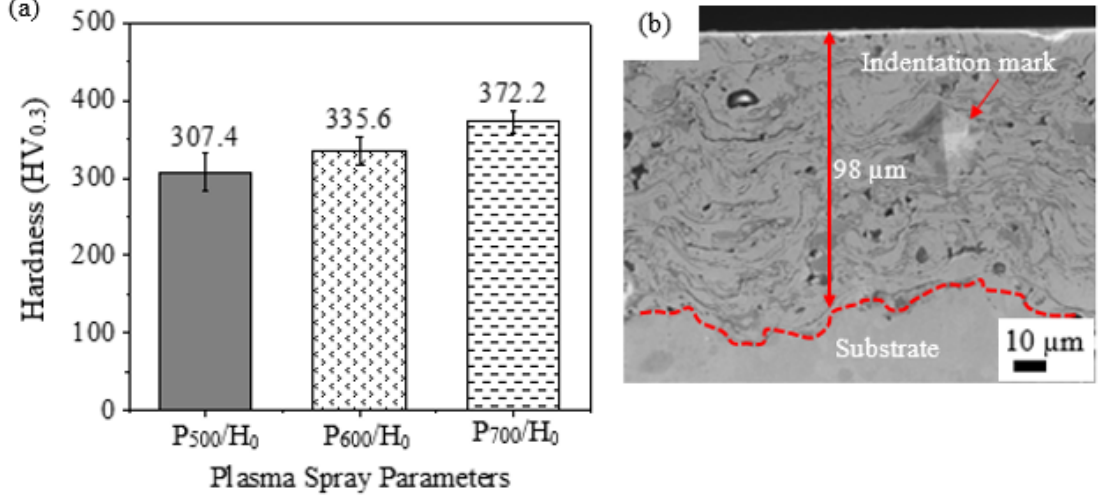
Figure 5. ( a ) Hardness of the as ‐ sprayed coatings with varying spraying powers and ( b ) SEM cross ‐ sectional image of the P 500 /H 0